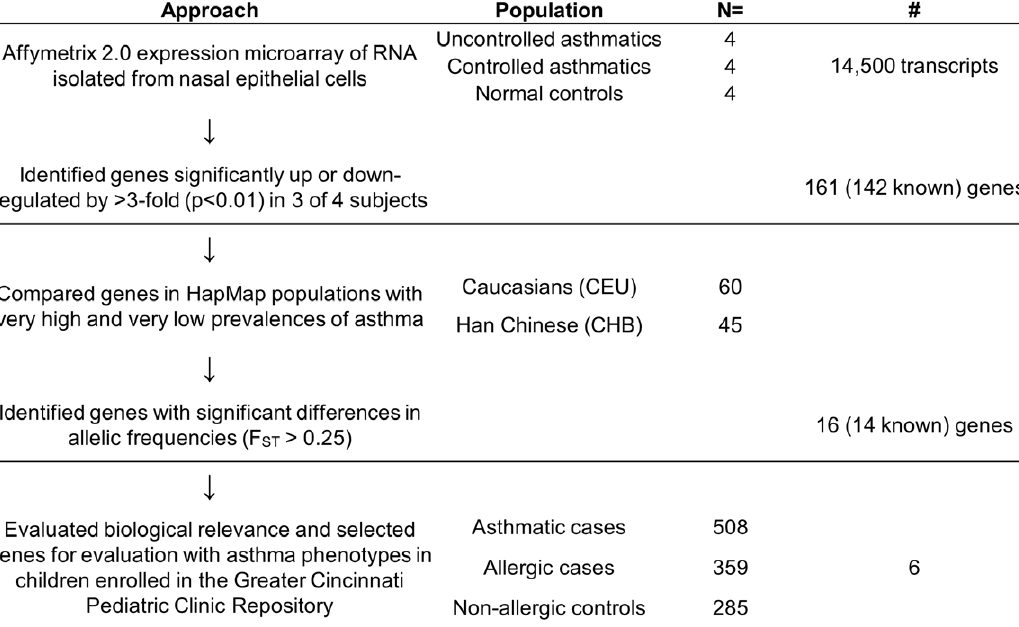
Figure 1. Novel unbiased approach to identify candidate asthma susceptibility genes. The approach consisted of three stages with an evaluation of RNA expression of 14,500 genes in nasal epithelial samples in stage 1. Next, 142 known genes with . 3-fold difference between uncontrolled asthmatics and non-allergic controls (P , 0.05) were taken forward to stage 2. In stage 2, using HapMap data, the allelic frequencies of Caucasians (Utah residents of European ancestry; CEU) and the Han Chinese (Beijing, China; CHB) were compared and 14 known genes with a fixation index (F ST ) . 0.25 were identified. Six of these genes, which mapped to chromosomal regions that had been linked to asthma previously, were included in the next phase. In stage 3, tagging SNPs including all CEU and YRI (Yoruban residents of Ibadan, Nigeria) SNPs with minor allele frequency less than 0.05 in the 6 genes were genotyped in children with asthma, allergic rhinitis or atopic dermatitis without asthma, and in non-allergic control children using a custom Illumina Golden Gate SNP Chip. Seven SNPs in a single gene, KIF3A , were significantly associated with asthma after adjusting for multiple comparisons (p-value , 0.0006).